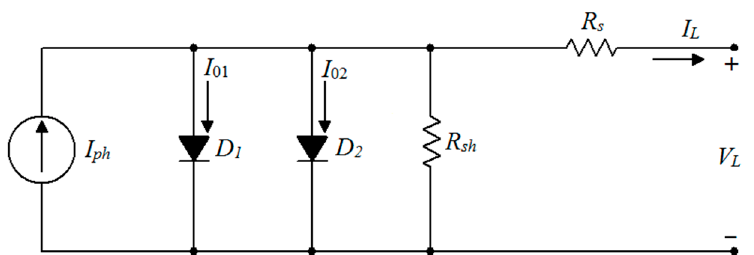
Figure 2. Double diode photovoltaic circuit model.